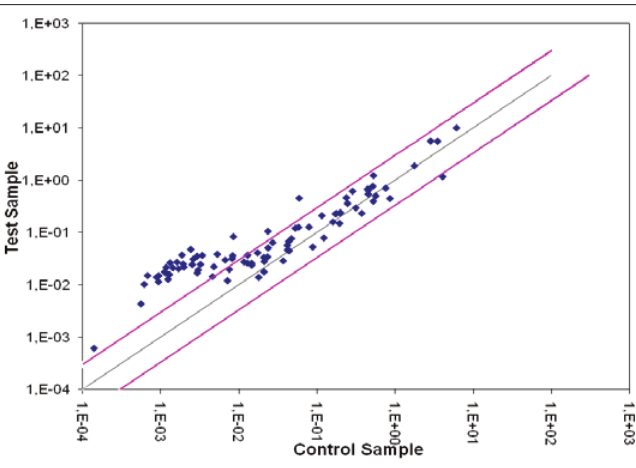
FIGURE 1 - Scatter plot allows the visualization of up and down fold- regulation of all gene expression investigated. The black line indicates fold changes [(2 ^ (-DC )] of 1. The pink lines indicate the threefold- t change in gene expression threshold.